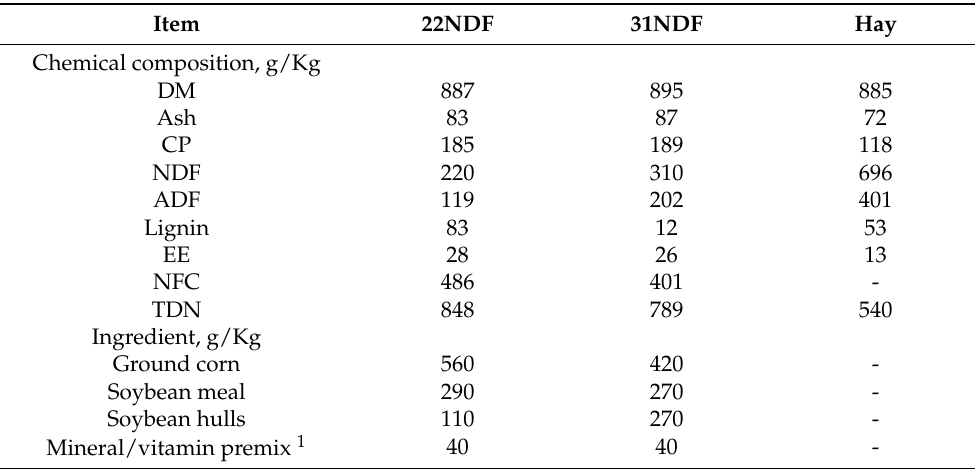
Table 1. Ingredient and chemical composition of experimental diets and